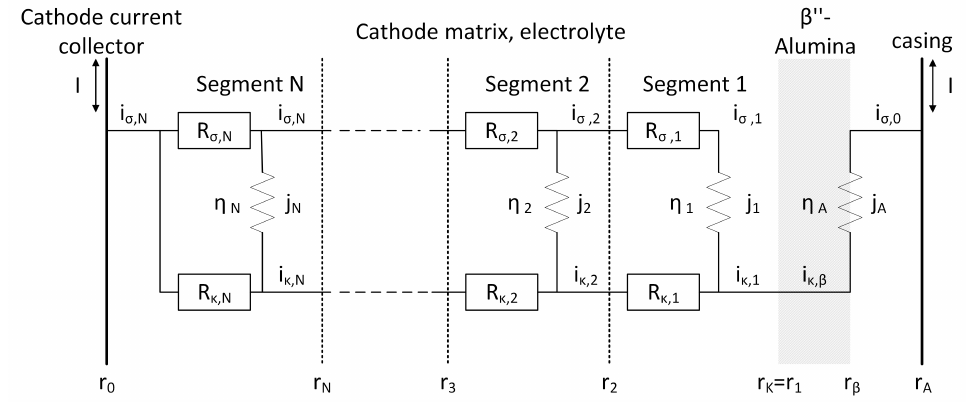
Figure 2. Equivalent circuit representing the segmented cathode space based on Orchard and Weaving